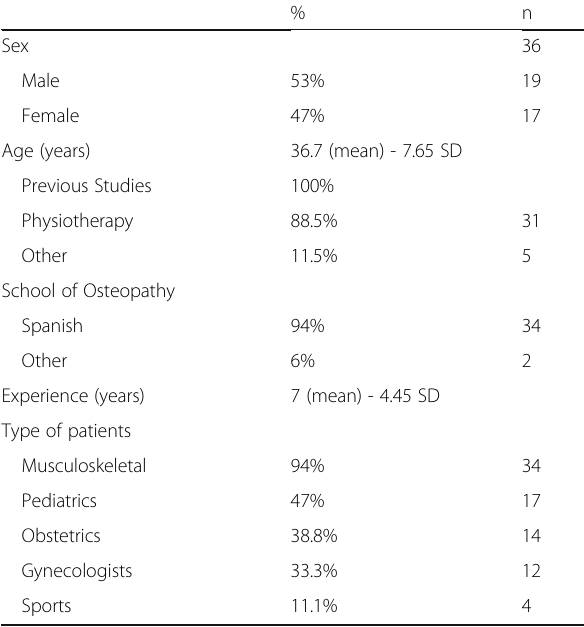
Table 6 Therapists socio-demographic